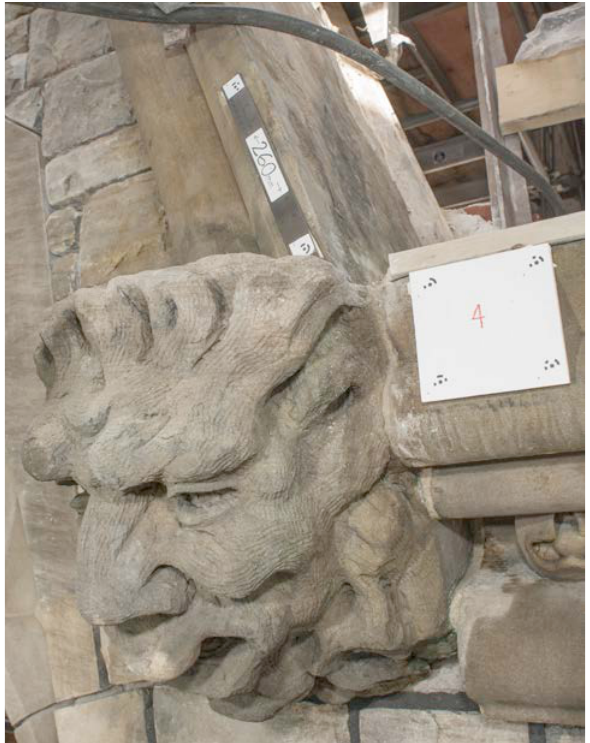
Figure 4. Photogrammetric image with known control points.